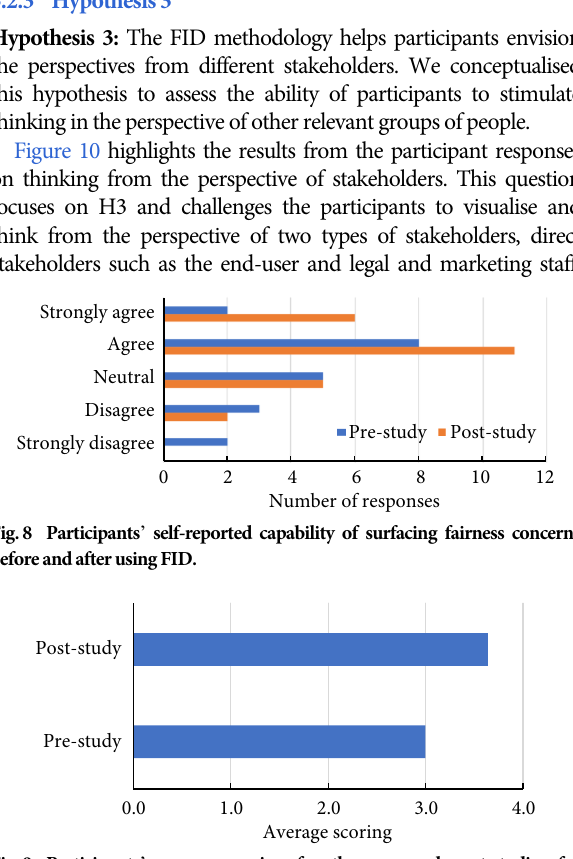
Fig. 11 Participants ’ average scoring for the pre- and post-studies for Hypothesis 3.